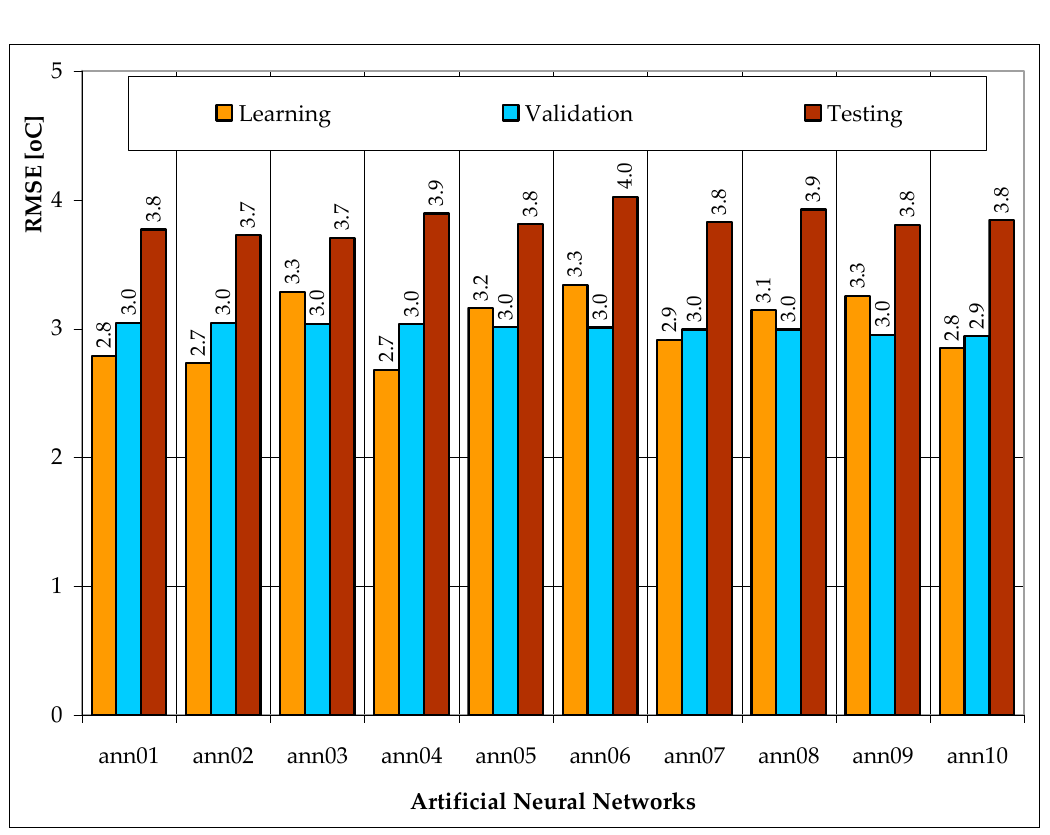
Figure 2. Values of RMSE for learning, validation and testing data sets.